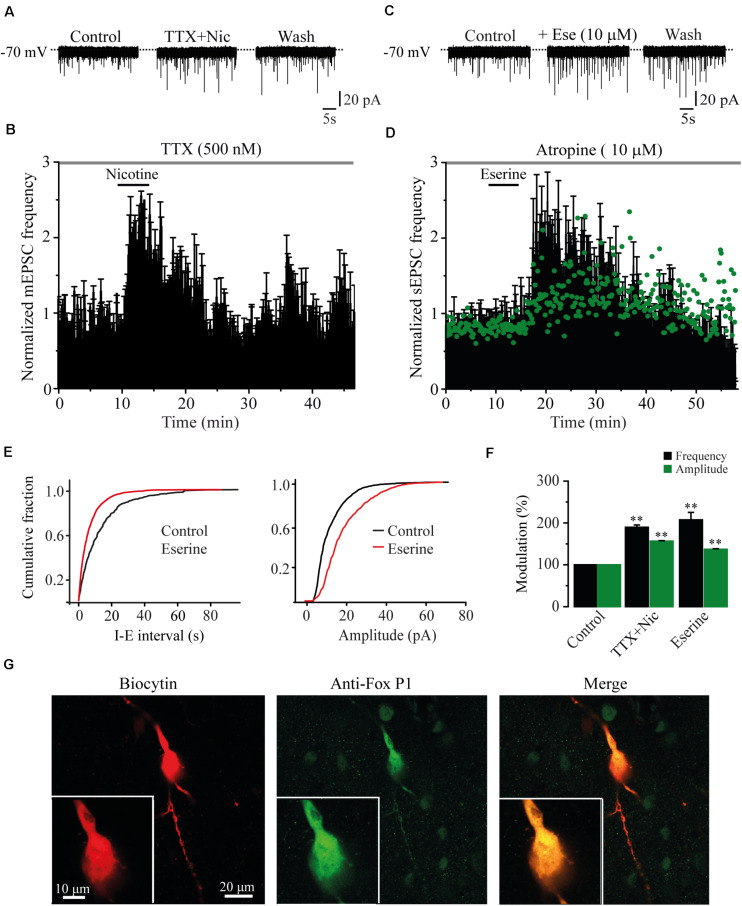
The effects of nicotine are not dependent of action potential. (A) Current traces showing sEPSCs in control condition (left), 10 min after nicotine plus TTX (500 nM, middle), and 20 min after nicotine washout (right). (B) Time-frequency histogram shows the temporal course of the effect of nicotine in the presence of TTX (n = 6). (C) Current traces showing sEPSCs in control condition (left); 10 min after eserine (10 μM, middle), an inhibitor of the enzyme acetylcholinesterase; and 20 min after eserine washout (right). (D) Time-frequency histogram shows the time course of the effect of eserine (n = 8). The graph in green, shows the time course of the amplitude. For clarity, the errors were removed from the graph. (E) Cumulative fraction plots (cell in C) of the inter-event interval (I–E, left) and amplitude (right) showing that eserine increased the frequency and amplitude of sEPSCs. (F) Summary of the results (Mann–Whitney U-test). (G) Same cell in A labeled with biocytin (left), anti-Fox P1 antibody (middle), and merge (right). Eserine experiments were performed in the presence of atropine (10 μM). **p < 0.01.